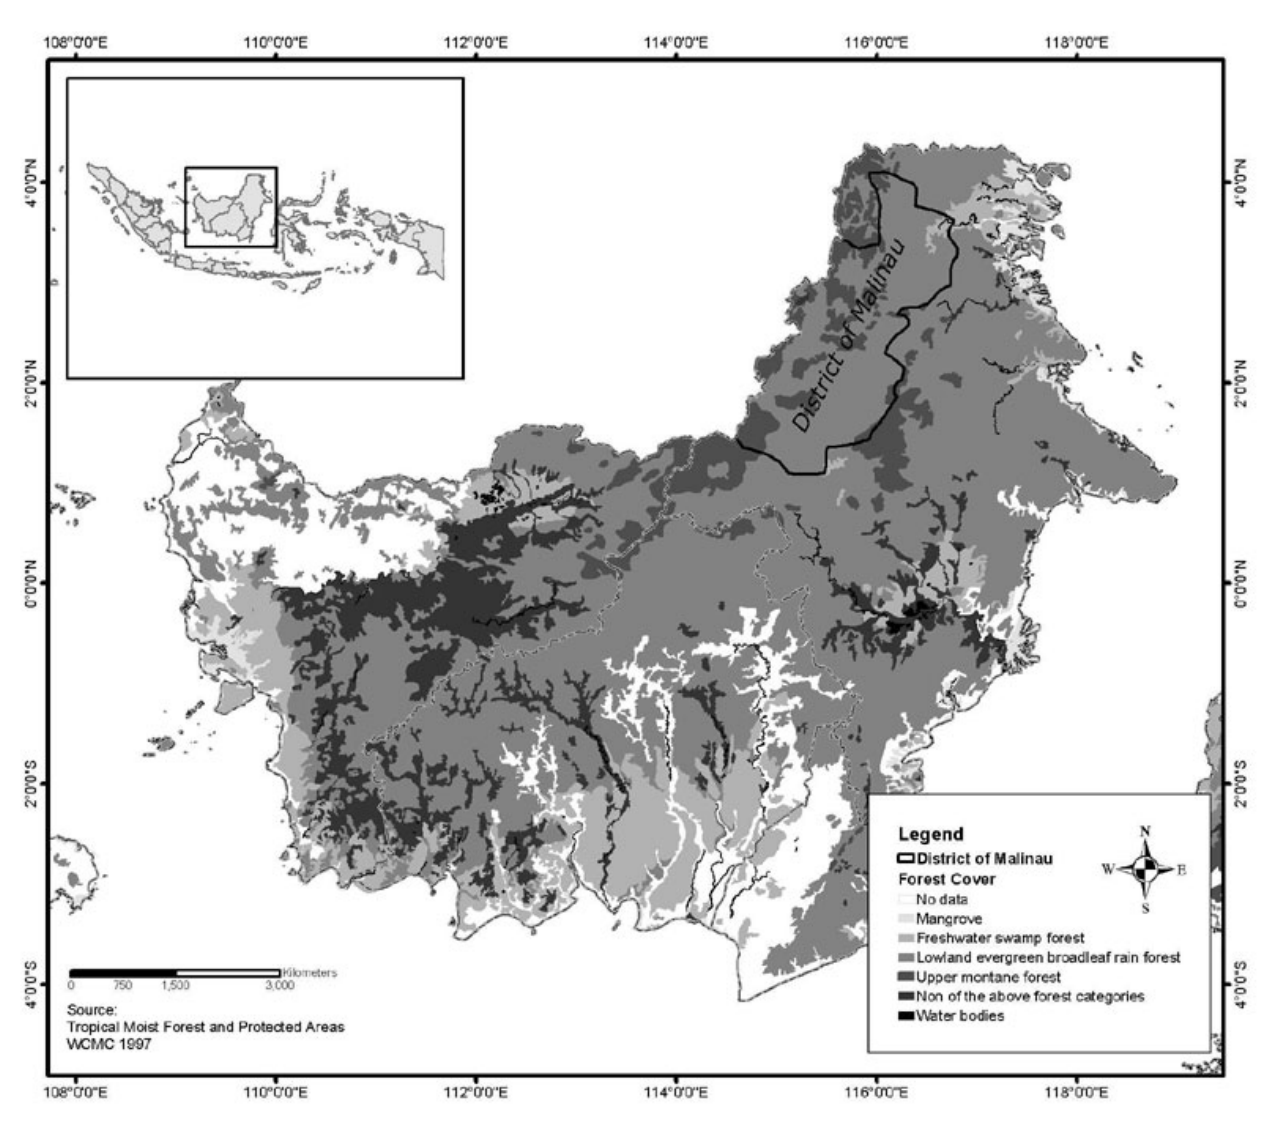
Fig. 1. District of Malinau, Indonesian